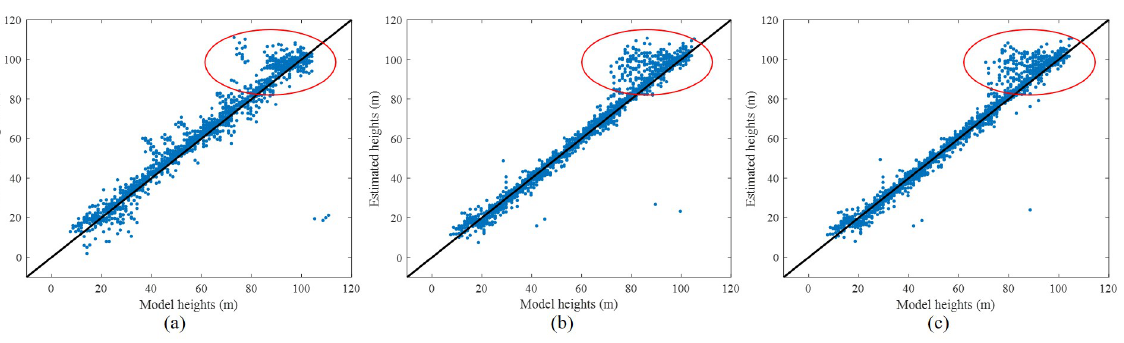
Figure 11. Joint distribution of the model height and estimated height of building 1: ( a ) TTNC,